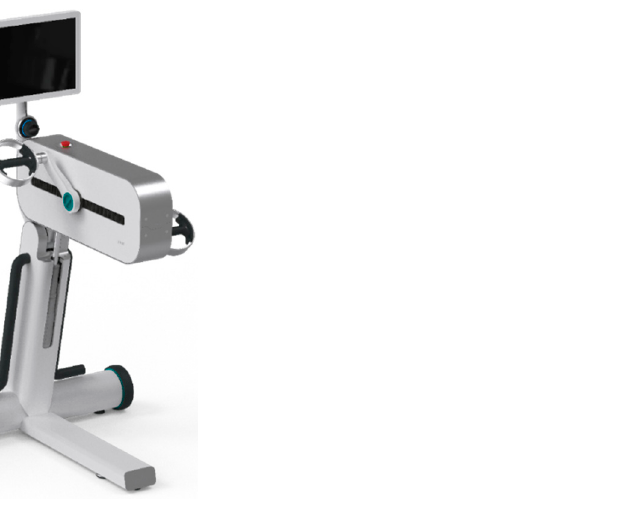
Figure 2. LEPRE Rehabilitation Device (Polibrixia s.r.l., Brescia, Italy). Rehabilitation of both upper and lower limbs is due to the device’s central body’s ability to tilt and thanks to the interchangeability of accessories, allowing for two setups: upper-limb configuration (Figure 3a) and lower-limb configuration (Figure 3b).